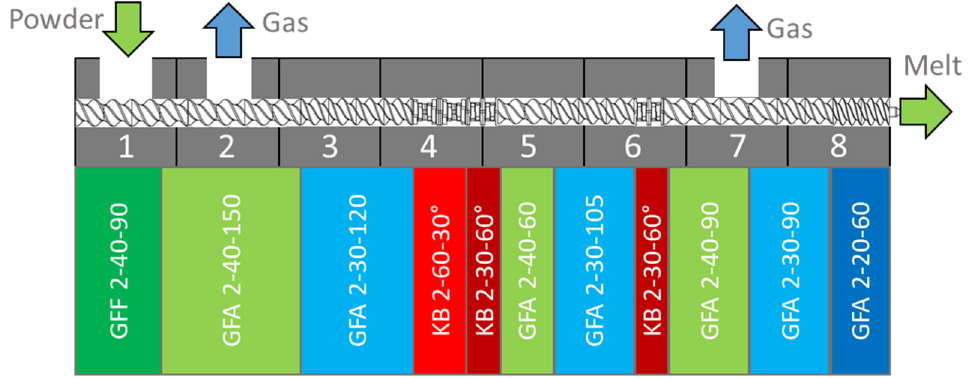
Figure 3. Screw and barrel configuration. Green and blue symbolize conveying elements, red marks kneading zones, the numbers indicate the cylinder elements. Nomenclature according to Leistritz.